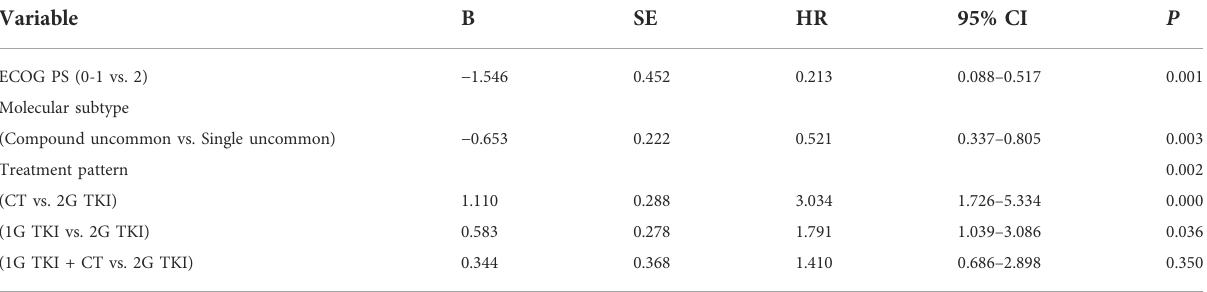
TABLE 4 Predictors for PFS by multivariate Cox regression.